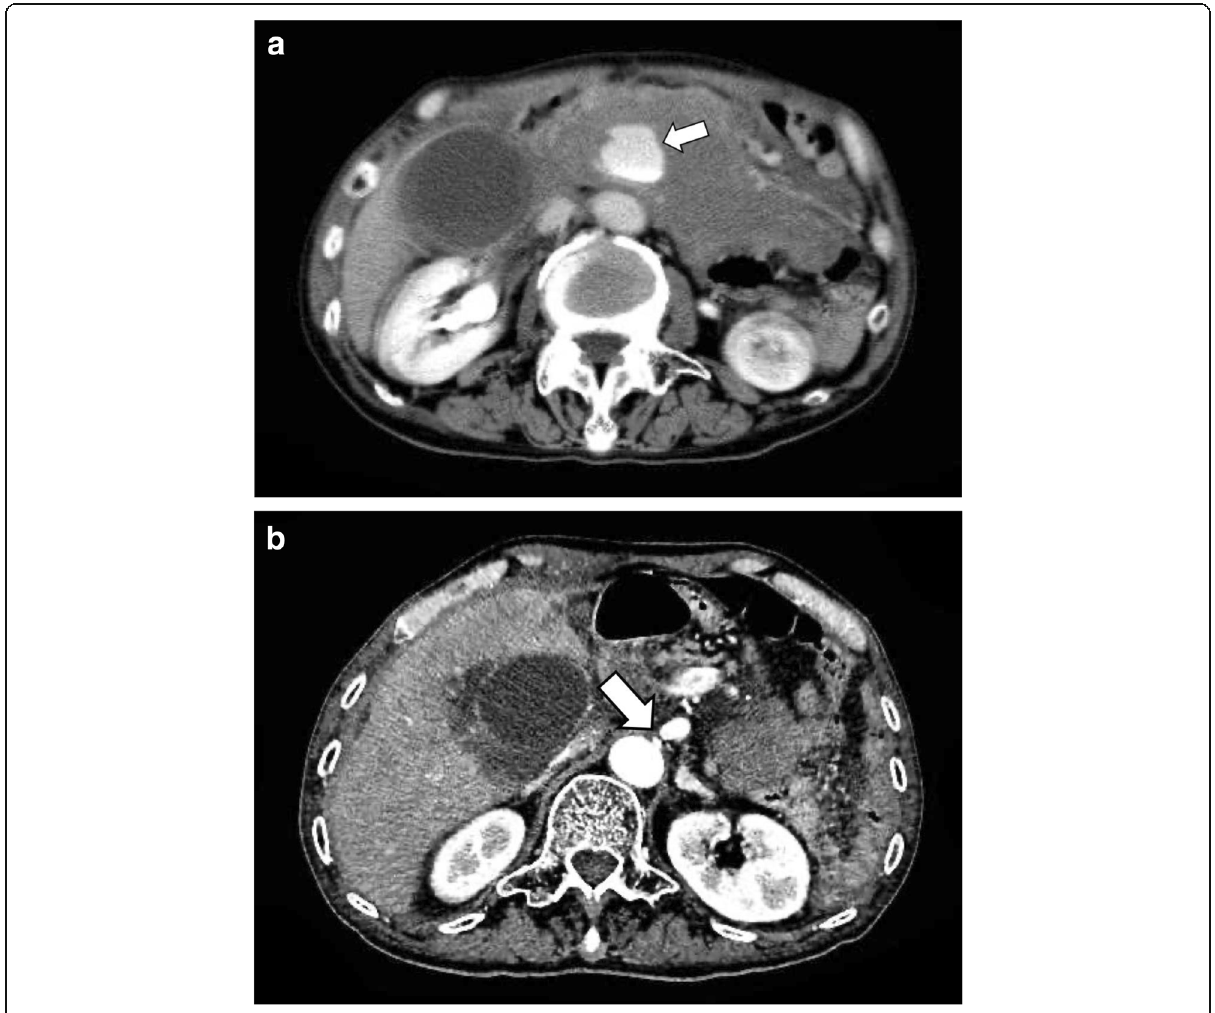
Fig. 1 a Computed tomography taken at visiting a physician showed a hematoma, and inferior pancreaticoduodenal artery aneurysm rupture was suspected (shown by arrow). b Computed tomography taken at visiting a physician showed stenosis of the root of the celiac axis (shown by arrow)